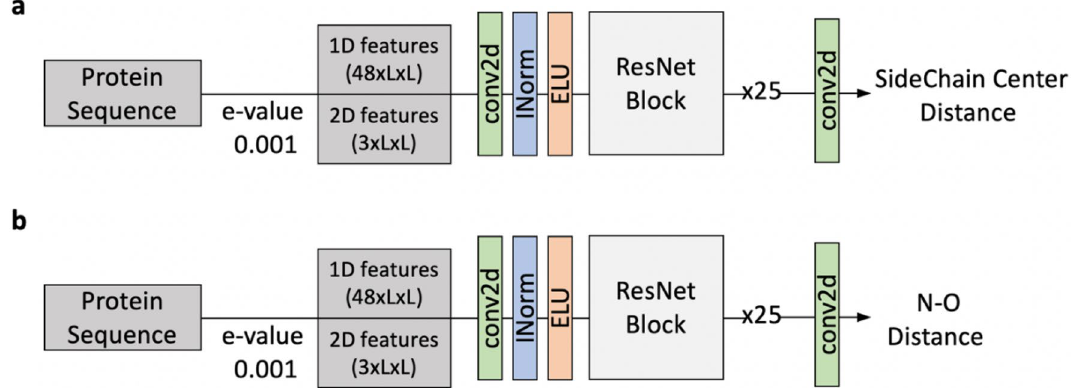
Figure 10. ResNet model architecture for ( a ) Sidechain Center (SCE) distances and ( b ) backbone peptide N–O pairwise distance prediction. The ResNet Block is the same as described in Fig. 1b. conv2d (green) is 2d convolution layer, INorm (blue) is instance normalization, ELU (orange) is Exponential Linear Unit.